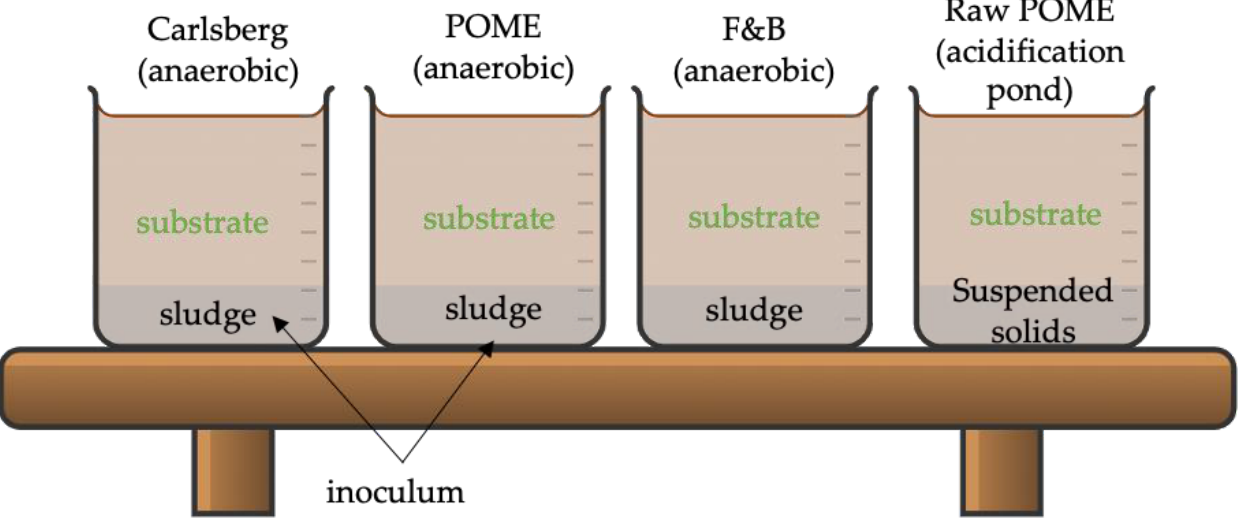
Figure 1. Inoculum and substrate preparation.